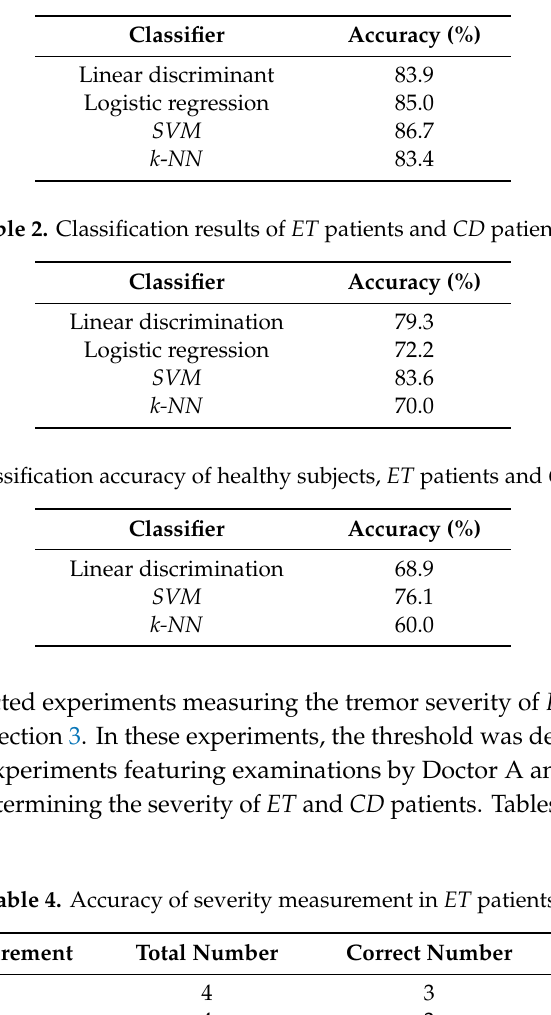
Table 1. Classification results of healthy subjects and tremor patients.